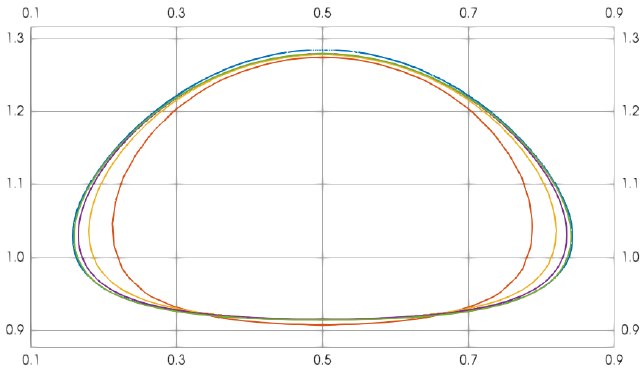
Figure 2. Bubble shapes at time t = 3 for h = 1/32 (red), h = 1/64 (yellow), h = 1/128 (purple), h = 1/256 (green), and reference from group 1 in [28]